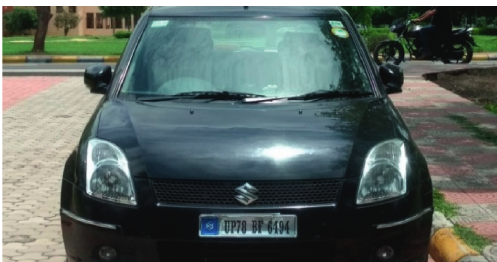
Figure 11: Original image for number plate